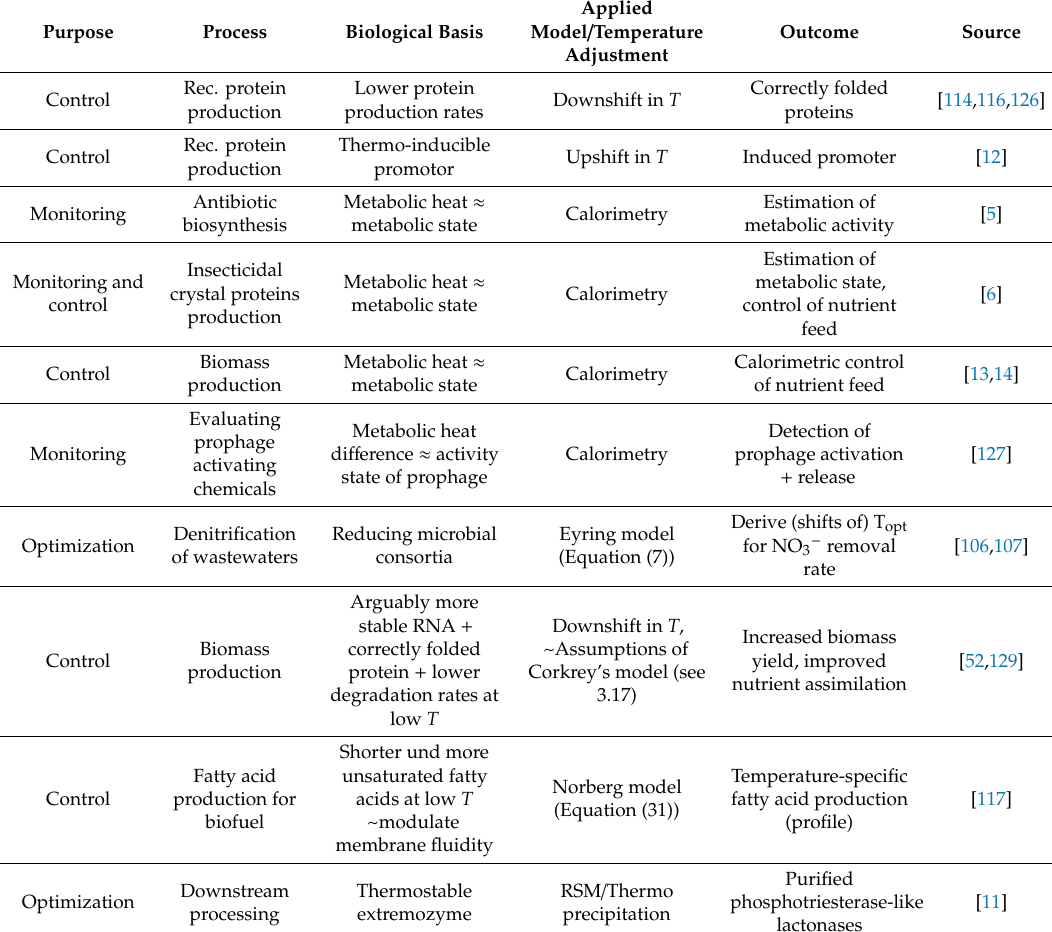
Table 2. Biological traits associated with modeling techniques and / or targeted temperature adjustments for the control, monitoring, and optimization of biotechnological